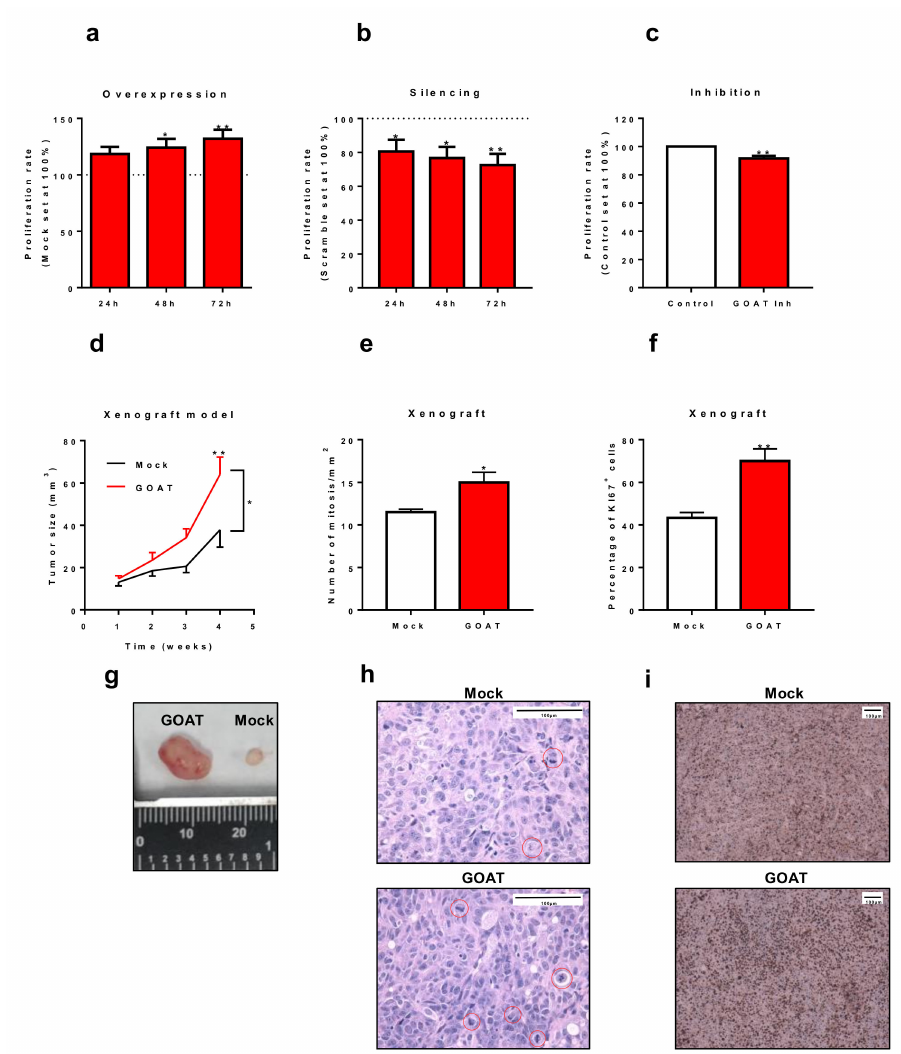
Figure 3. E ff ects of GOAT in vitro and in vivo. Cell proliferation rate (determined by Alamar-Blue assay) at 24, 48 and / or 72 h in response to GOAT overexpression ( a ), silencing ( b ) and pharmacological blockade with the specific GOAT inhibitor GO-CoA-Tat ( c ). Results are referred as a percentage of the control condition (mock, scramble and vehicle-treated cells, respectively). ( d ) Comparison between the growth of xenograft tumors derived from mock-transfected cells (black line) and GOAT-overexpressing cells ( red line ) over time. ( e ) Number of mitosis per mm 2 in the xenograft tumors derived from mock-transfected DU145 cells and GOAT-overexpressing DU145 cells. ( f ) Percentage of positive KI67 cells in mock and GOAT xenograft tumors. ( g ) Representative image of tumor size of mock and GOAT xenograft tumors. ( h ) Representative image of xenograft tumors derived from mock-transfected DU145 cells and GOAT-overexpressing DU145 cells with hematoxylin-eosin staining. ( i ) Representative images of KI67 staining of xenograft tumors derived from mock-transfected DU145 cells and GOAT-overexpressing DU145 cells. The asterisks (*, p < 0.05; **, p < 0.01) indicate values that significantly di ff er between